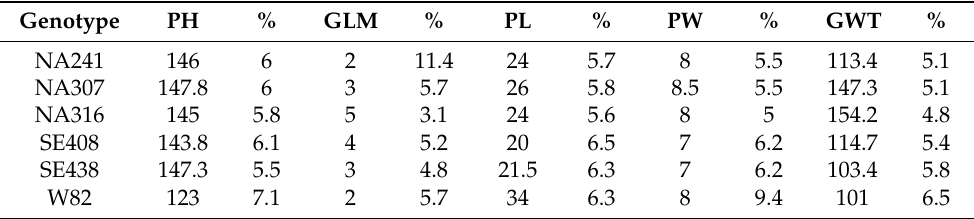
Table 1. Best performing BC 2 F 2 sorghum genotypes.